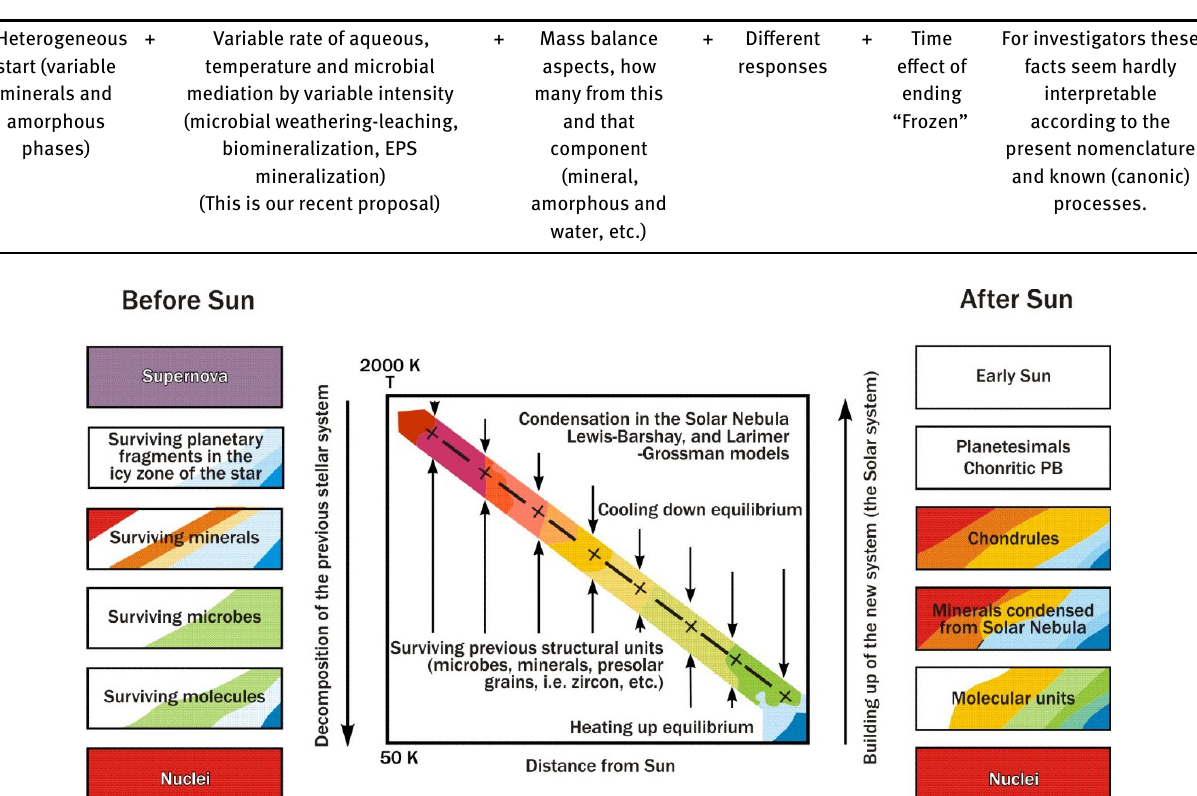
Figure 7. Proposed condensation-evaporation “hysteresis” range in the primordial Solar System. Condensation (after Sun objects, right coloumn) and evaporation (previous objects surviving the formation of the Sun, left coloumn) in a hierarchical sequence, top larger, bottom smaller. Legend of colors: violet- supernova; red - high temperature (refractory) minerals; orange - dry rock-forming minerals; yellow - hydrated silicates; green - microbes; light blue and dark blue - ices; dark red at bottom - nuclei (isotopes).